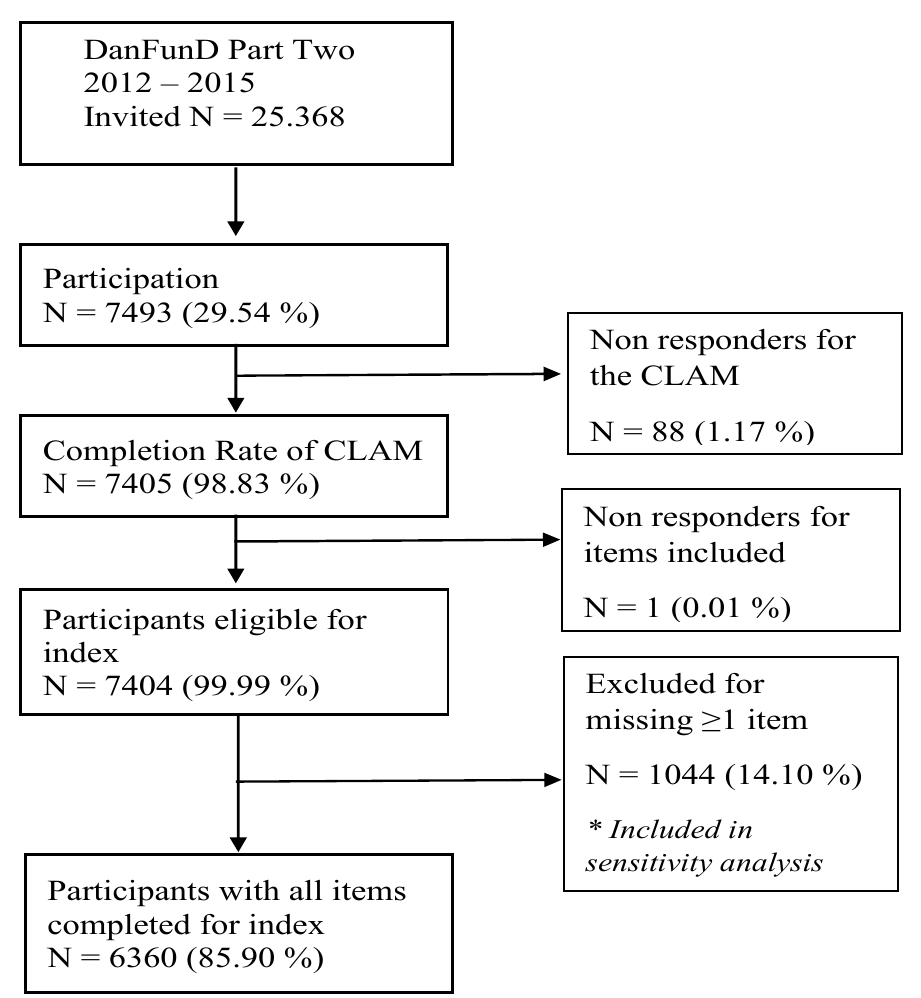
Figure 1. Flow Chart of participation.